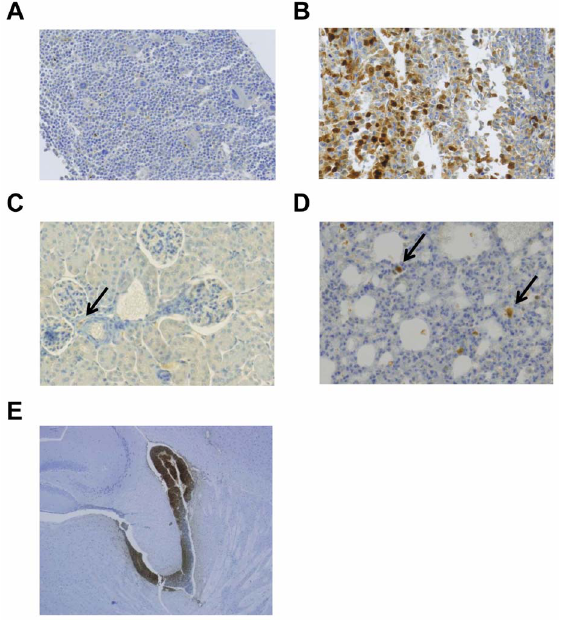
Figure 2. GFP expression in bone marrow, kidney, lung and brain from mice injected with Raji B-cells. GFP expression ( brown ) was analyzed by immunohistochemistry in fixed specimens of bone marrow Raji GFP (A), bone marrow Raji GFP-ZAP-70 (B), kidney (C), lung (D) (x20) and brain (E) (x4.2) from mice injected with Raji B-cells. Images from bone marrow show a representative mouse from each group and representative specimens from mice injected with Raji-GFP-ZAP-70 cells are shown in the other images. Slides were counterstained with hematoxylin.